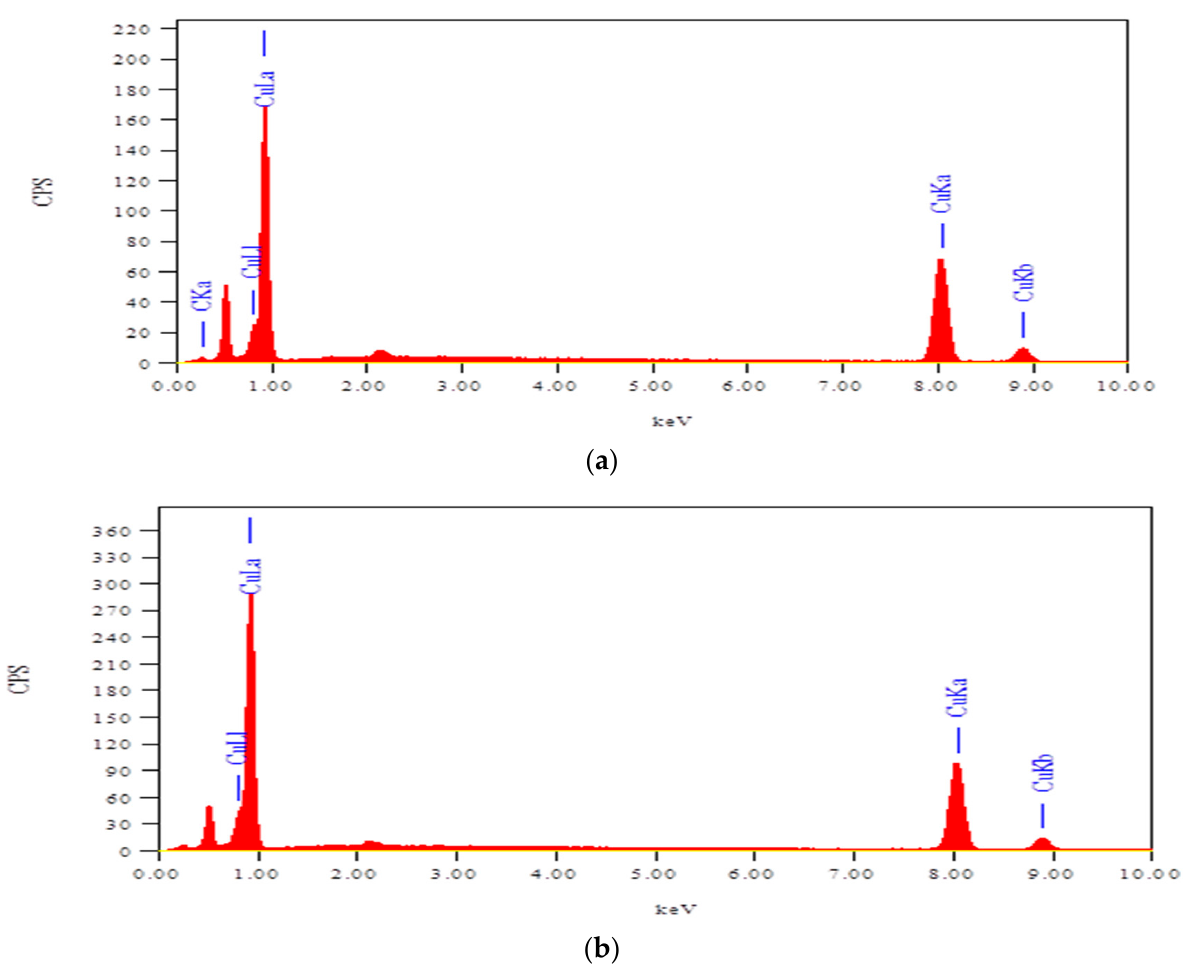
Figure 10. EDAX analysis at ( a ) 0.125 M rGO/CuO and ( b ) 1.0 M rGO/CuO.